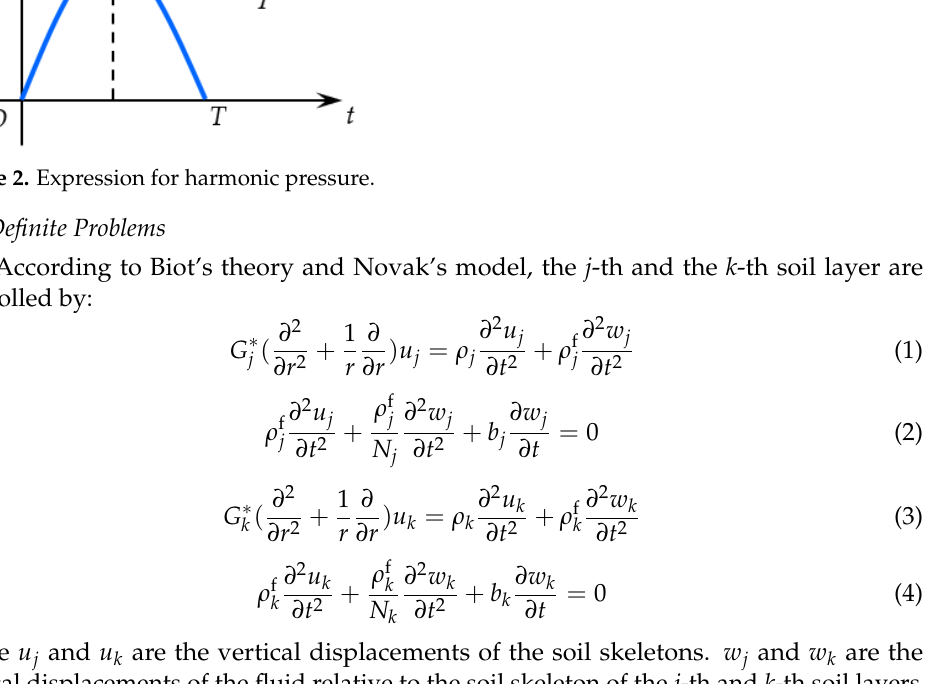
Figure 2. Expression for harmonic pressure.